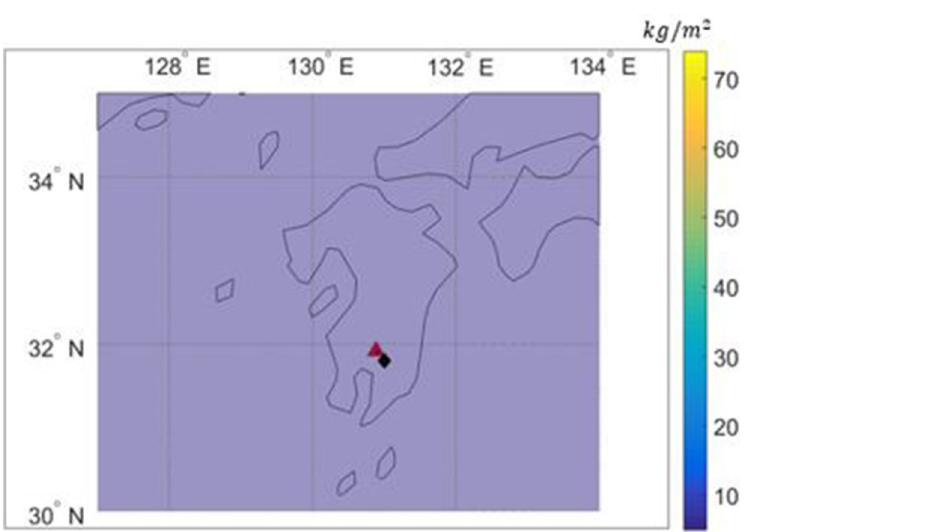
Figure 9. Prediction of ash deposition from the Shinmoedake volcano eruption from Jan. 26 to 27, 2011 by the PUFF–UAF